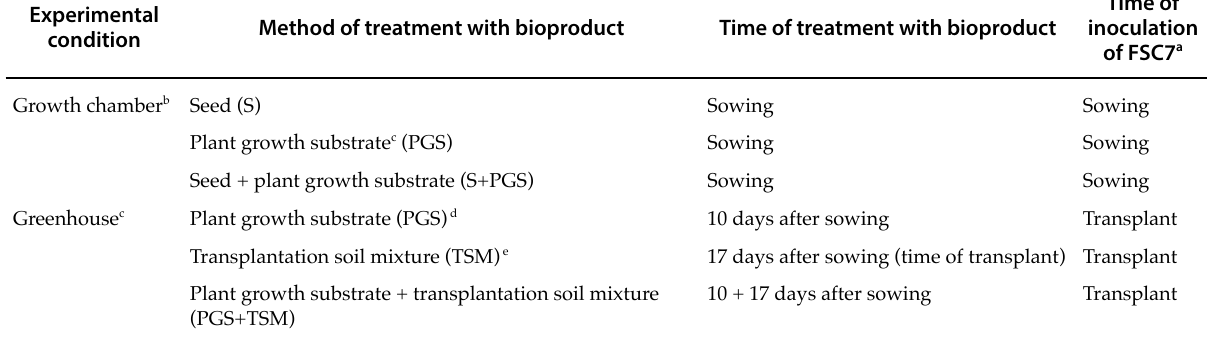
Table 2. Description and abbreviations of treatments with bioproducts applied in growth chamber and greenhouse